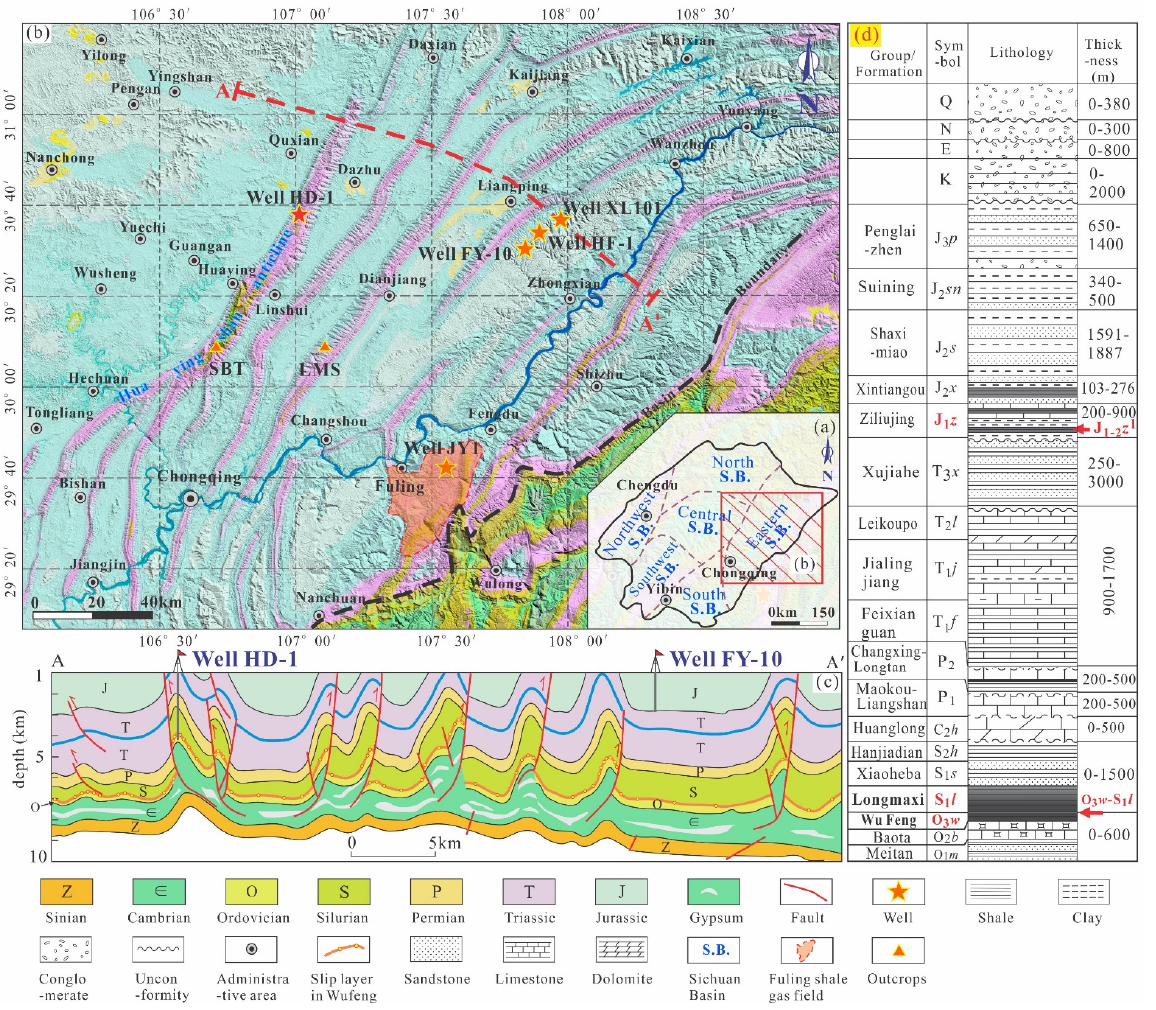
Figure 1. Geological overview of Sichuan Basin and the distribution of the study area. ( a ) The shape and structure units of Sichuan Basin. ( b ) Map of the Eastern Sichuan Basin showing the geomorphological features in the study area and the location of wells and outcrops. ( c ) The structural profile of Eastern Sichuan Basin showing the structure style and the location of well HD-1 and well FY-10. ( d ) Stratigraphic column of Eastern Sichuan Basin showing the vertical configuration relationship between marine and lacustrine shale.